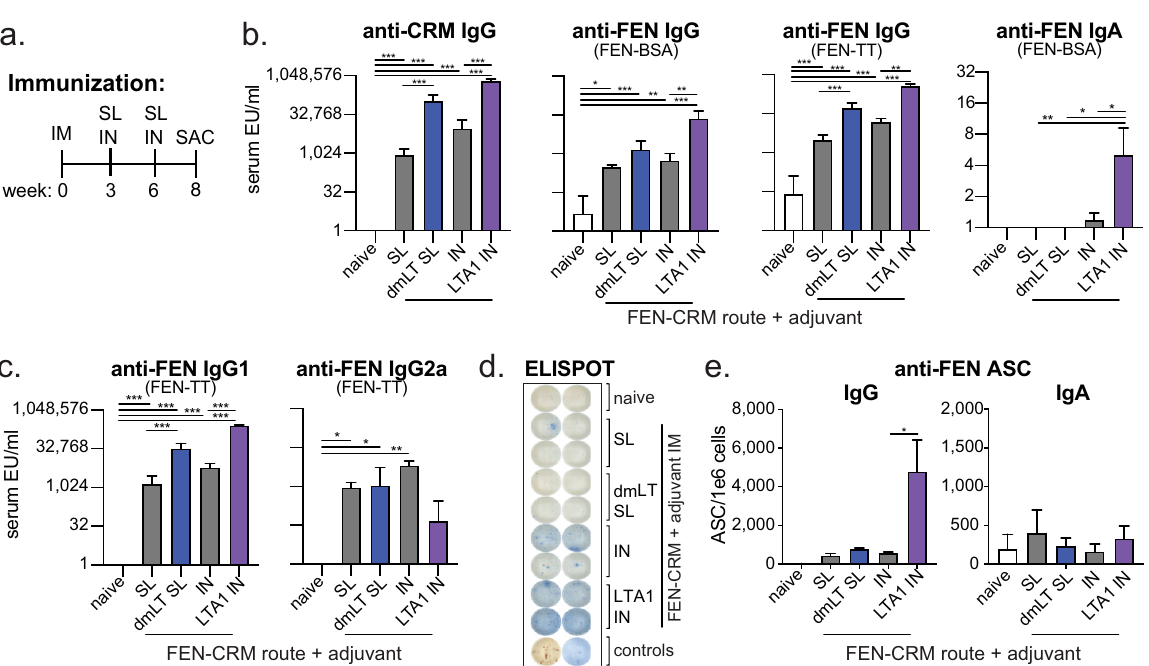
Fig. 4 Immune responses to FEN-CRM 197 can be generated by sublingual or intranasal booster immunizations containing either dmLT or LTA1 adjuvants. Groups of Balb/c mice ( n = 6) were left naïve or primed by 5 μ g FEN-CRM ± 0.1 μ g of dmLTor 5 μ g of LTA1 by IM delivery. Mice were boosted mucosally on weeks 3 and 6 with 9 – 10 μ g FEN-CRM ± 5 μ g dmLT SL or 9 μ g FEN-CRM ± 5 μ g LTA1 IN, both in 30 μ l. On week 8, serum and bone-marrow were collected for immune response evaluation. a Schematic of immunization schedule. b Compiled serum anti-CRM and anti-FEN (FEN-BSA, FEN-TT) serum IgG ELISAs. c Compiled serum anti-FEN (FEN-TT) serum IgG1 or IgG2a ELISAs. d Representative anti-FEN (TT-BSA coated) IgG/IgA ELISPOT images from bone-marrow. Blue spots indicate IgG and red spots IgA ASCs. d Compiled serum anti-FEN (FEN-BSA) IgA ELISA. e Compiled anti-FEN IgG ASC per 10 6 cells from bone-marrow. Bars at mean + s.e.m. with signi fi cance determined by ANOVA paired with Bonferroni post-hoc test as shown (* P < 0.05, ** P < 0.01, *** P <